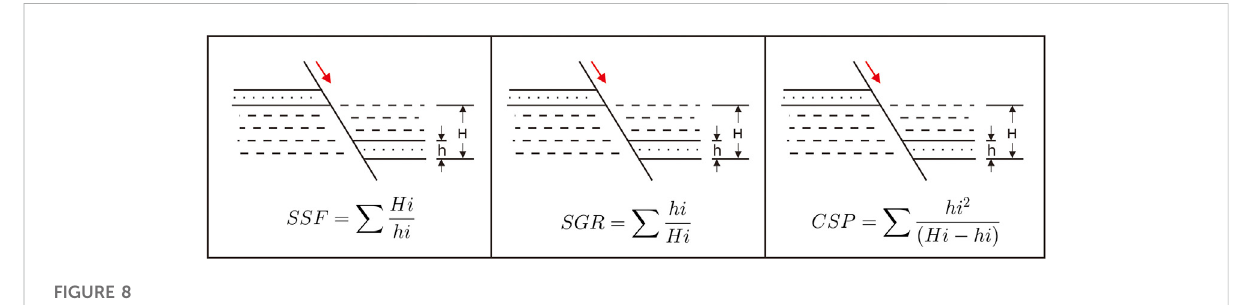
FIGURE 8 Quantitative methods of the shale